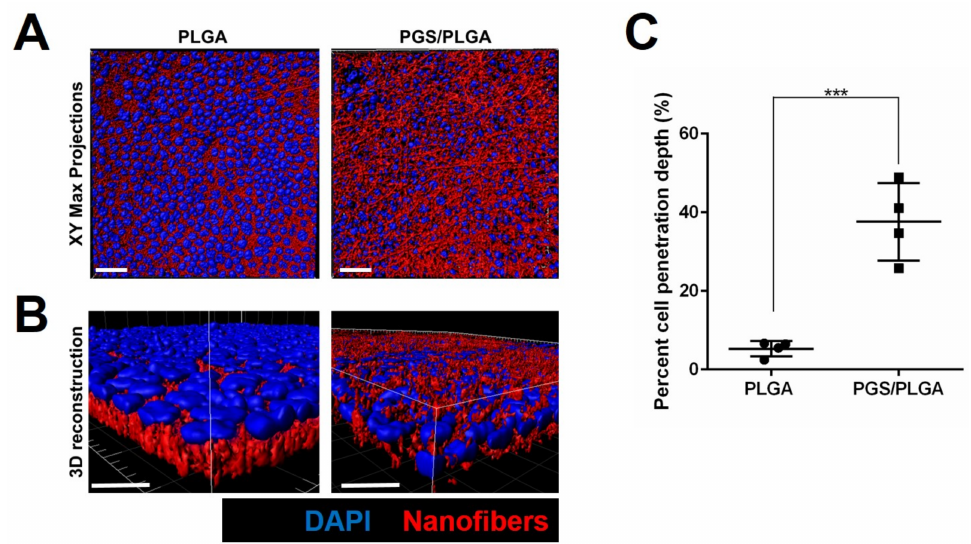
Figure 5. PGS/PLGA nanofibers promote cell penetration into scaffolds. ( A , B ) SIMS cells were cultured on PLGA or PGS/PLGA scaffolds (red) for 7 days and stained for DAPI (blue). IMARIS 3D reconstructions of Z-stacks suggest cell penetration into PGS/PLGA nanofiber mats. Scale bars, 50 µ m and 10 µ m for ( A , B ), respectively. ( C ) Quantification of cell nuclei penetration into PLGA and PGS/PLGA nanofiber scaffolds. Data are means ± SD ( n = 4). *** p < 0.001 unpaired students t